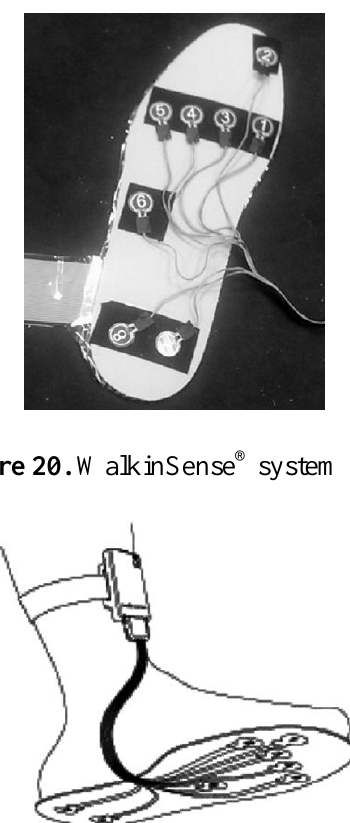
Figure 19. WalkinSense ® sensor placement [51].